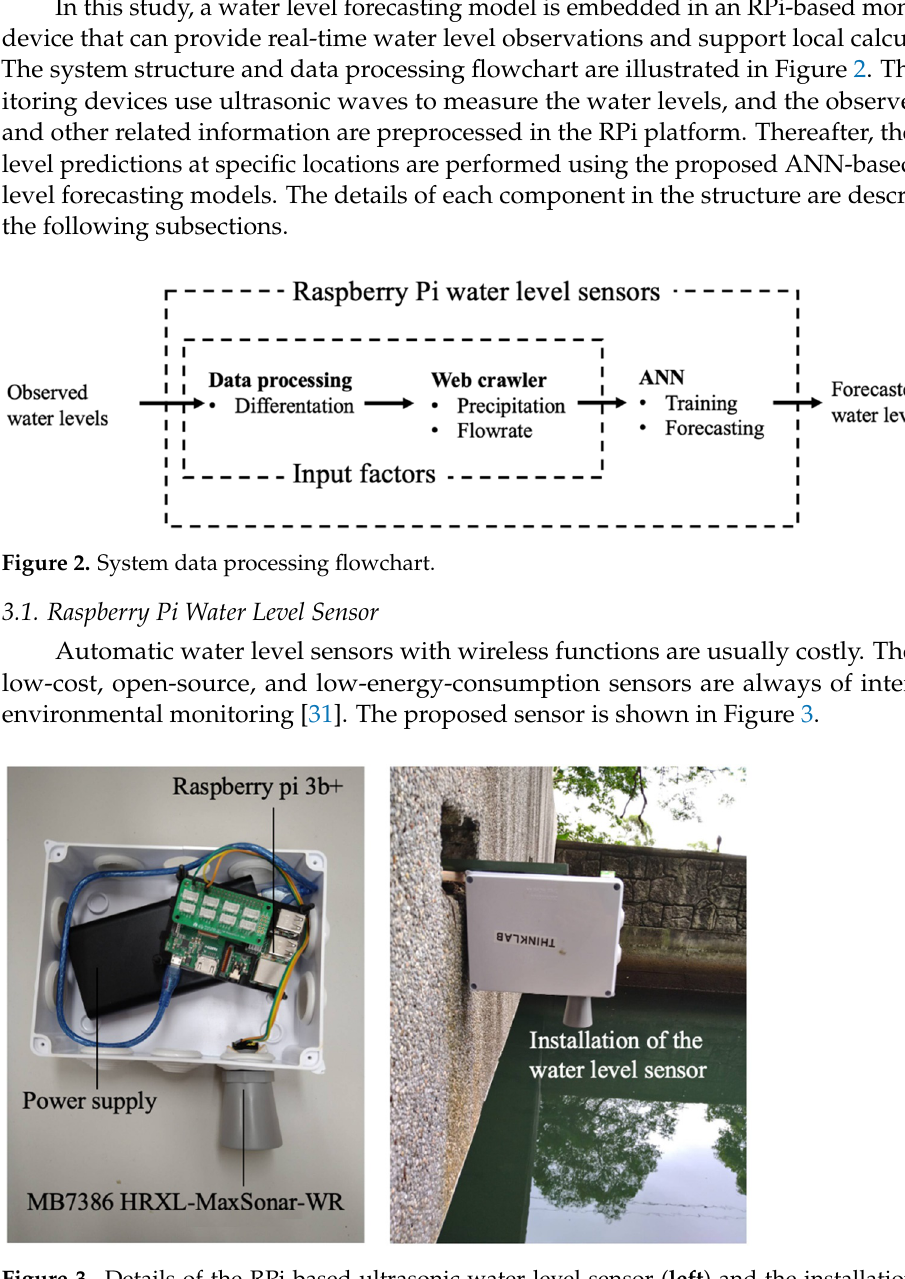
Figure 3. Details of the RPi-based ultrasonic water level sensor ( left ) and the installation of the sensor ( right ).